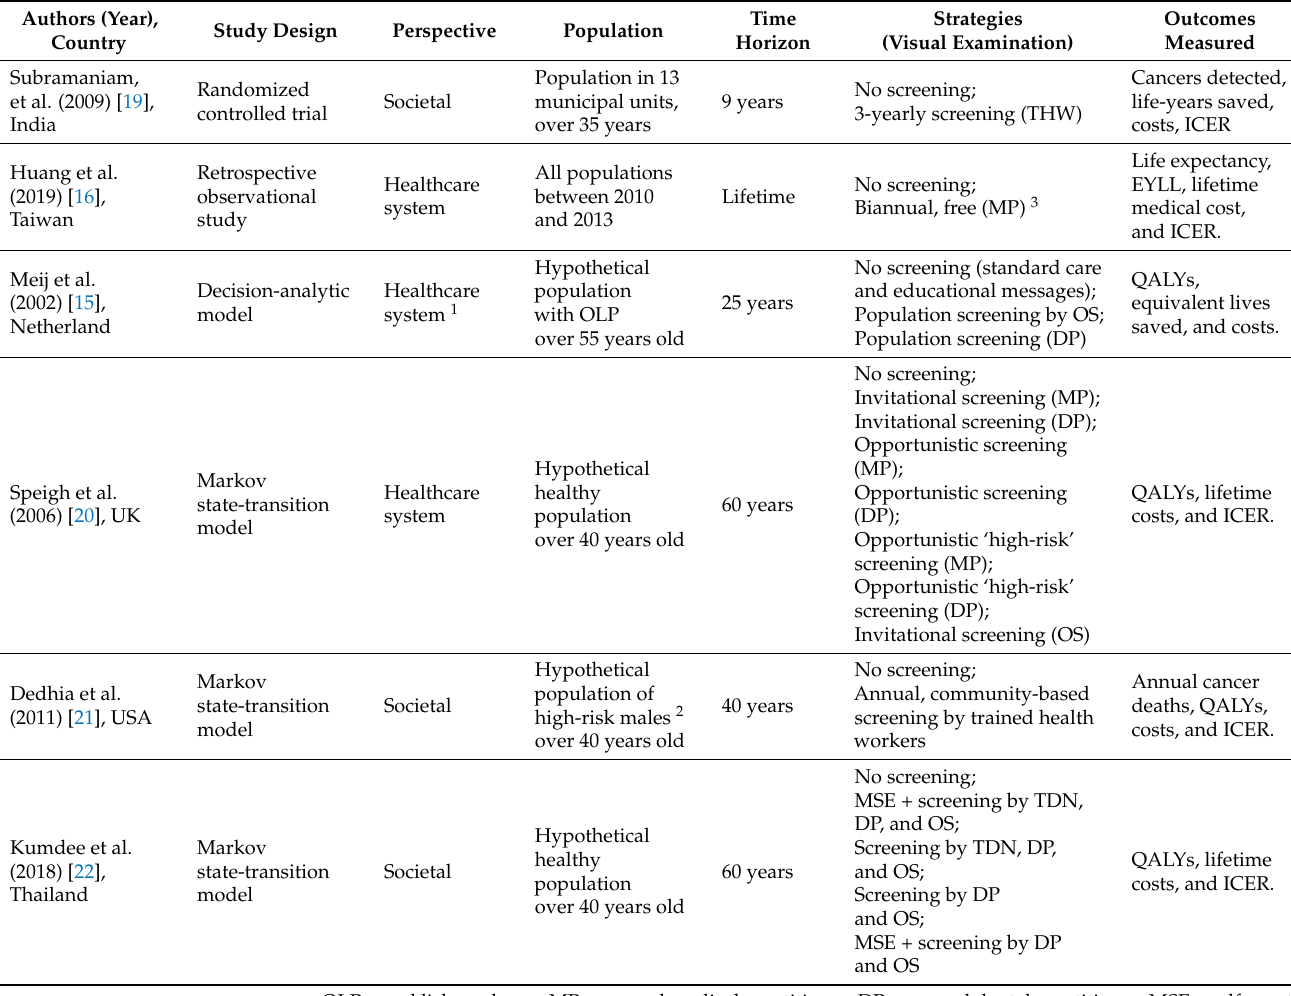
Table 2. Summary of studies included for quality assessment and